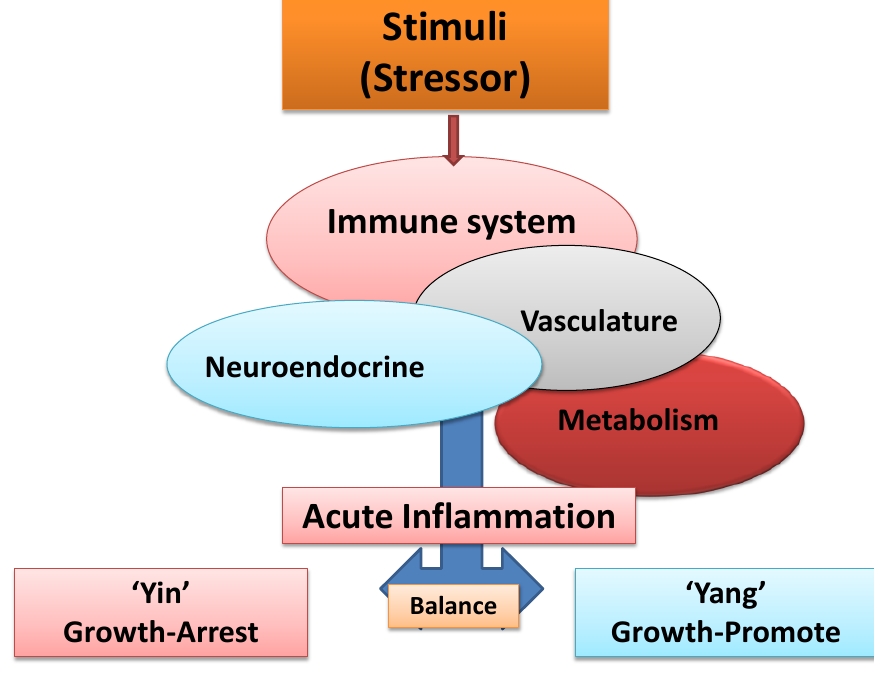
Figure 1. Schematic representation of balance between ―Yin‖ (growth-arresting) and ―Yang‖ (growth-promoting) of acute inflammation. Inflammatory processes involve elaborate, precise and interdependent cross-talk between immune and non-immune systems (e.g., vasculature, neuroendocrine and metabolic pathways) to combat and destroy foreign elements and injured host tissue and to neutralize, resolve and terminate inflammation and repair and reconstruct the damaged